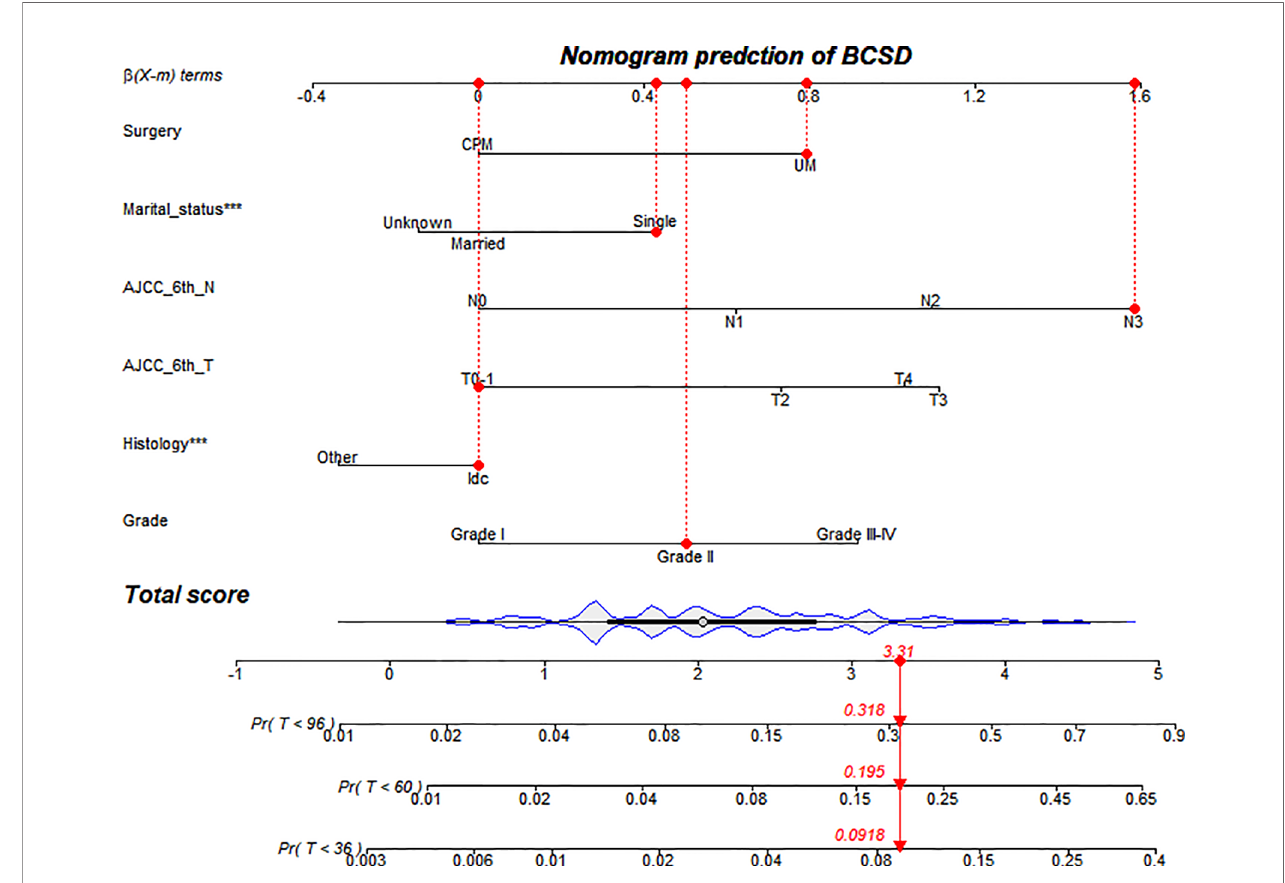
FIGURE 4 | Competing risks regression nomogram model for MaBC